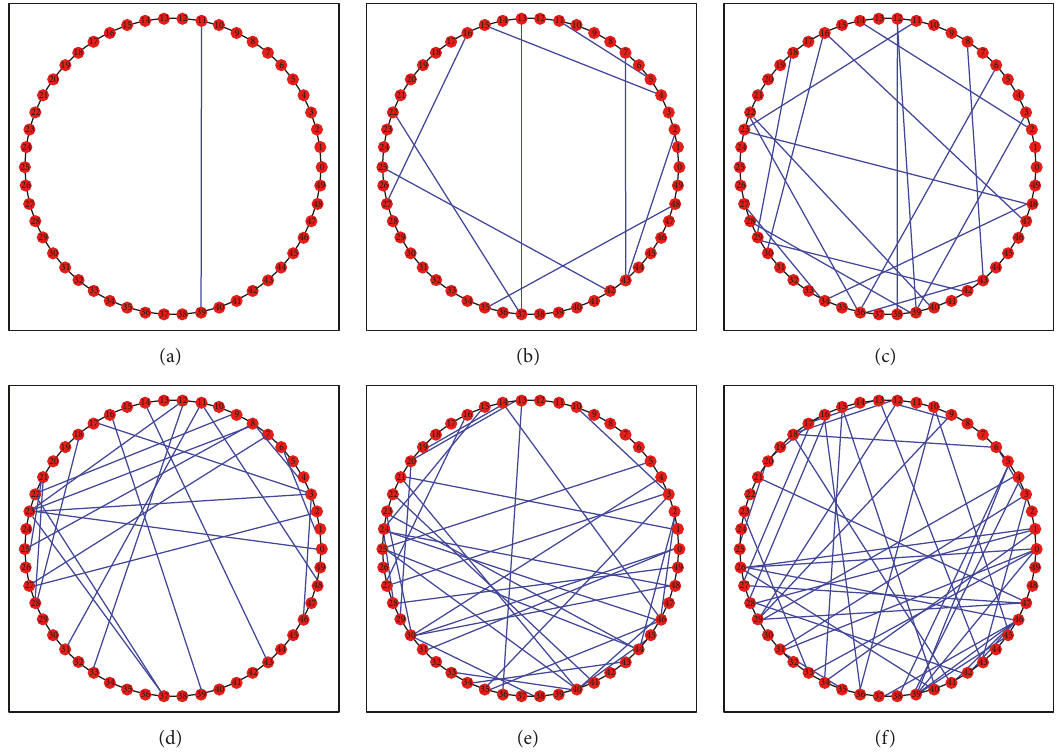
Figure 5: Optimizing results for improving efficiency of transforming a regular network into a small-world network. The figures show the topological structure of the NW model for adding edges. (a) shows the topology of the original regular network. (b)–(f) show the topology as k edges are added ( k = 10, 20, 30, 40,